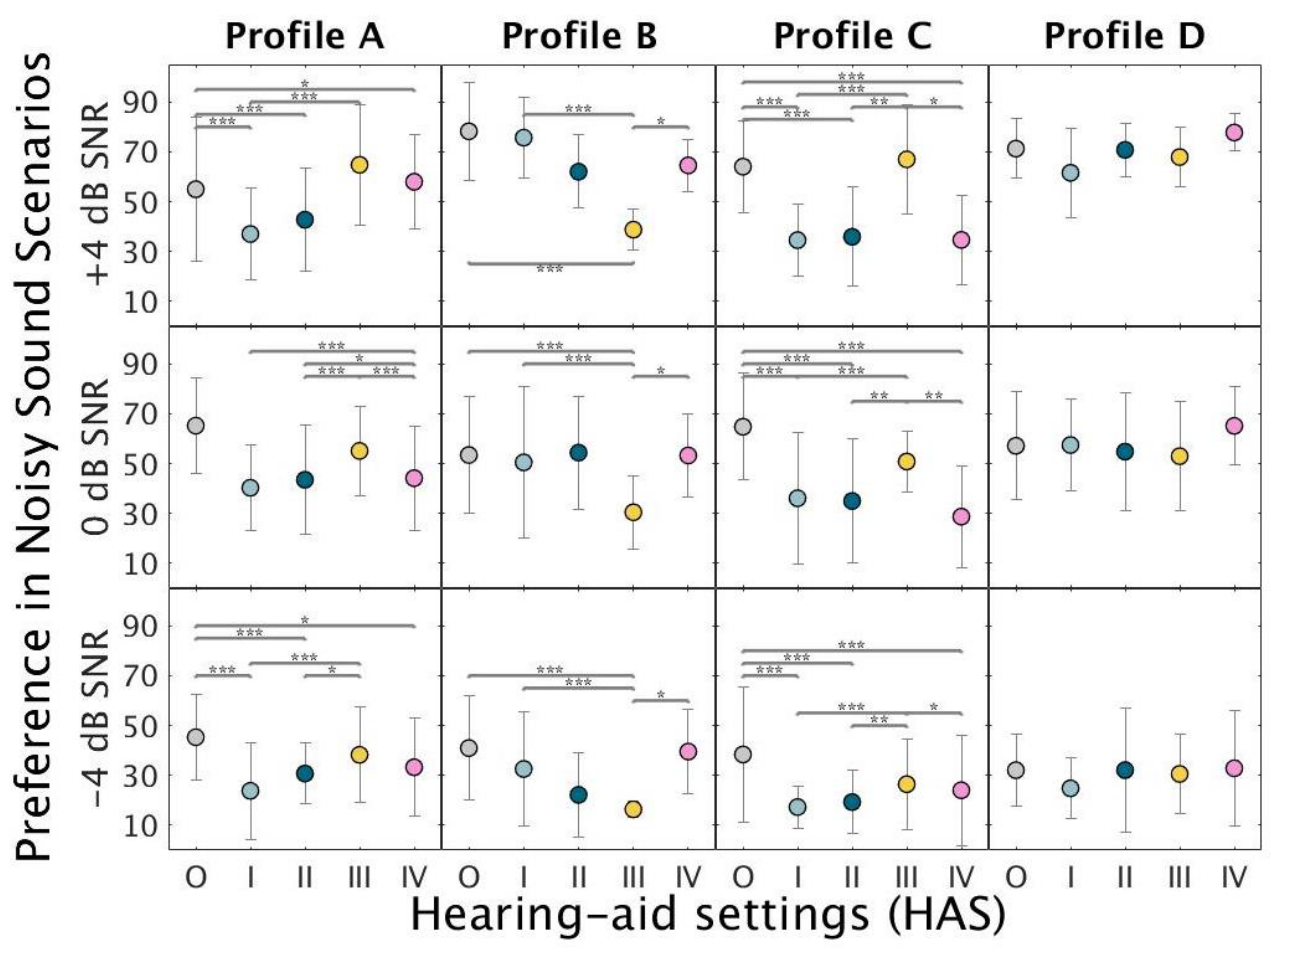
Figure 4. Mean preference ratings for the evaluated HAS (O-IV) under noisy conditions across the three SNR conditions: − 4 dB SNR (bottom panels), 0 dB SNR (middle panels) and +4 dB SNR (top panels). Each circle represents the mean of the scores of the three repetitions performed in each noisy sound scenario (traffic and cafeteria) by the listeners belonging to profile A ( left ), B ( mid-left ), C ( mid-right ), and D ( right ). Error bars show ±1 standard deviation. Significant differences according to a linear mixed model (Appendix A) analysis, followed by Tukey’s honest significant differences tests are marked by asterisks. (***) p < 0.0001, (**) p < 0.001, (*) p <